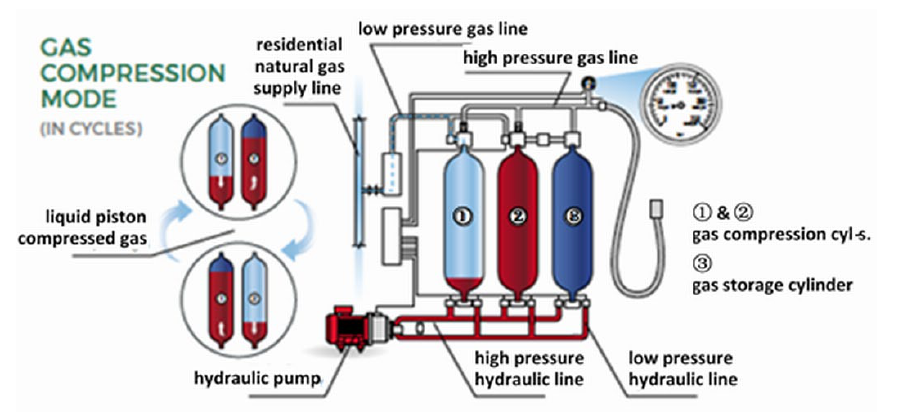
Fig. 2. Hydraulic piston compressor and